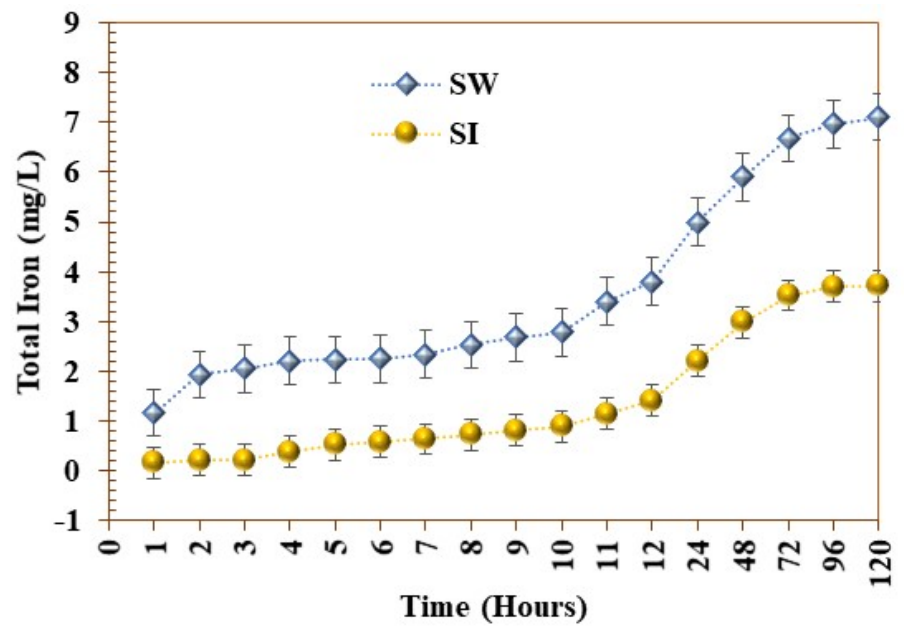
Figure 2. Comparison of iron dissolution by 2 mM 1, 10 Phenanthroline from SI and SW materials for 120 h. Experimental conditions: Mass of each Fe 0 = 0.1 g, Volume of working solution, V = 50 mL, room temperature, T = 37 ± 0.5 °C.